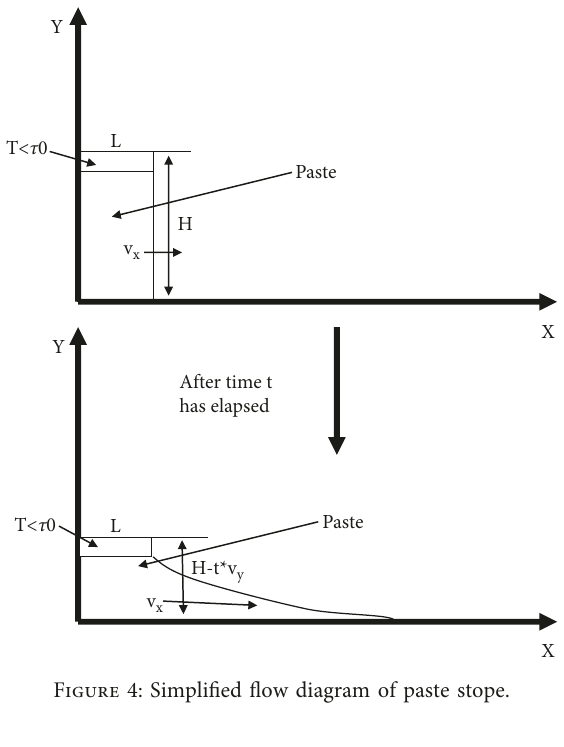
Figure 4: Simplified flow diagram of paste stope.